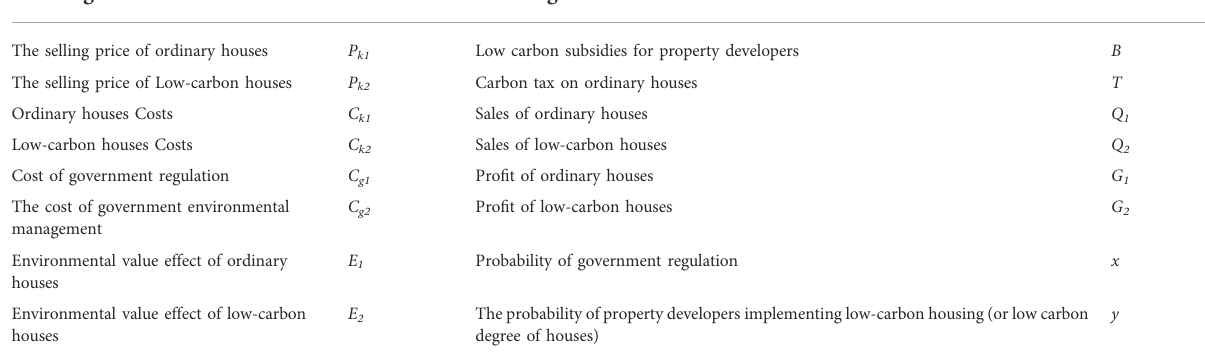
TABLE 1 Details of main variables.